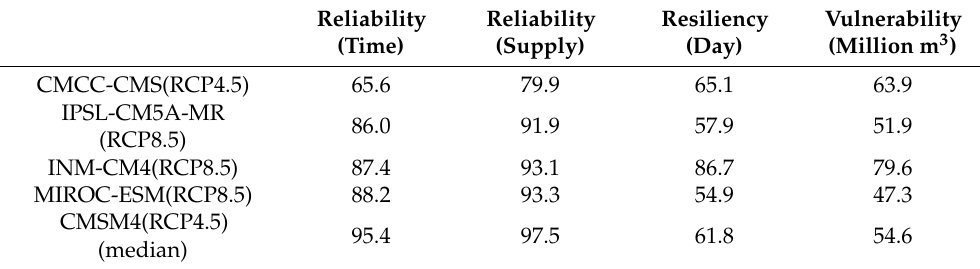
Table 5. Termination criteria at each